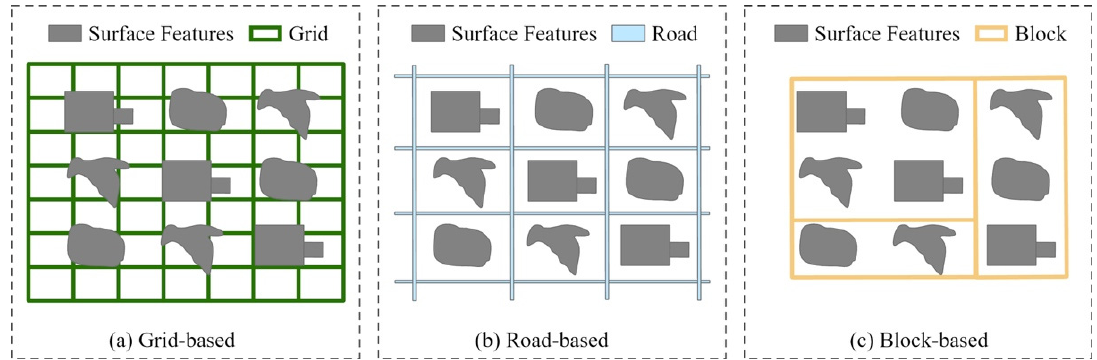
Figure 1. Examples of different zone segmentation methods.